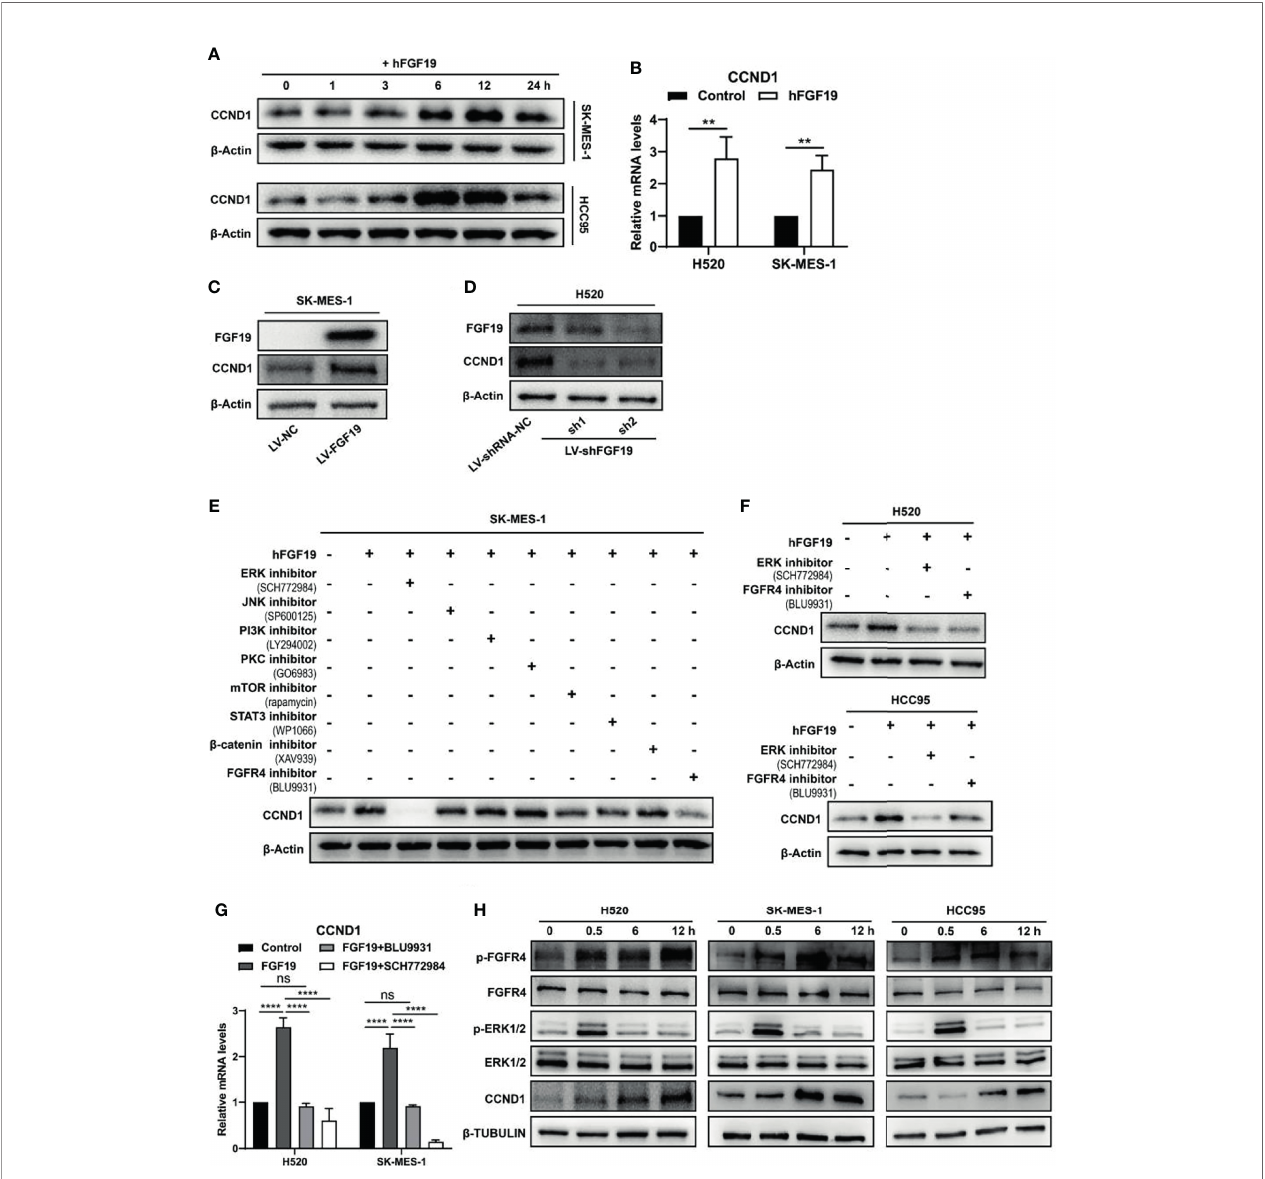
FIGURE 2 | FGF19 enhances CCND1 expression by FGF19-FGFR4-ERK1/2 axis in LUSC cells. (A) Recombinant human FGF19 (rhFGF19) (25 ng/ml) promoted expression of CCND1 in SK-MES-1 and H520 cells (serum starved for 12 h before treatment) in a time-dependent manner. (B) CCND1 mRNA expression levels in LUSC celllines after treatment with rhFGF2 for 12 h. (C) Expression ofCCND1 in FGF19 overexpression LUSC cellline. (D) Expression of CCND1 inFGF19 knockdown LUSC cellline. (E) A panel of inhibitors againsta number of signaling pathwayswas used to dissect the leading factorsof regulated byFGF19. (F) Westernblot and (G) qPCR analysisofCCND1 expression in H520 and HCC95 LUSC cells after treatment of FGF19, FGF19 and SCH772984, FGF19 & BLU9931, or DMSO as control. (H) Effects ofthe FGF19/FGFR4 pathway on protein levelsof CCND1, p-FGFR4, and p-ERK1/2by western blot analysis. H520, SK-MES-1 andHCC95 cellswere treated with FGF19 (25 ng/ml,0/0.5/6/12 h)to activate the FGF19/FGFR4 signalingpathway. Data were shownas mean ± SDbars and compared byunpaired t -test. ** p < 0.01; **** p < 0.0001; ns, not signi fi